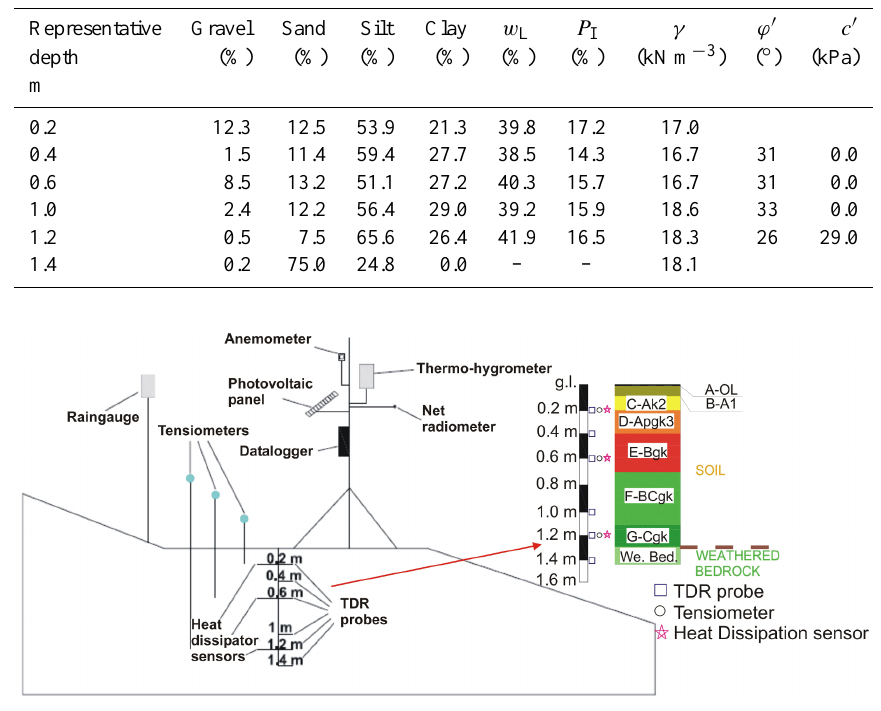
Figure 4. Schematic representation of the monitoring station installed in the study area.